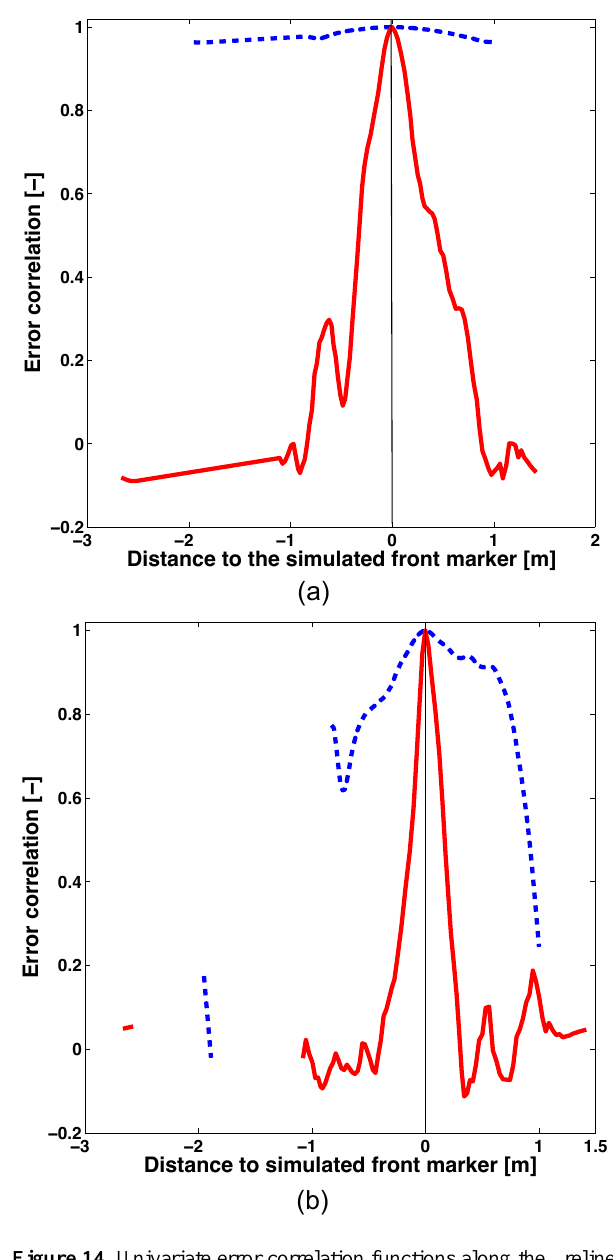
Figure 14. Univariate error correlation functions along the fireline associated to one marker location (the vertical bar represents its ref- erence location indexed by m in Fig. 13a) – controlled grassland fire experiment over the assimilation cycle [ 50 ; 64s ] . (a) Error correla- tion of the reference marker x coordinate with respect to the errors in the x coordinates of the other markers along the fireline: the blue dashed (red solid) line corresponds to the mean forecast (analysis) estimate. (b) Error correlation of the reference marker y coordinate with respect to the errors in the y coordinates of the other markers along the fireline: the blue dashed (red solid) line corresponds to the mean forecast (analysis)